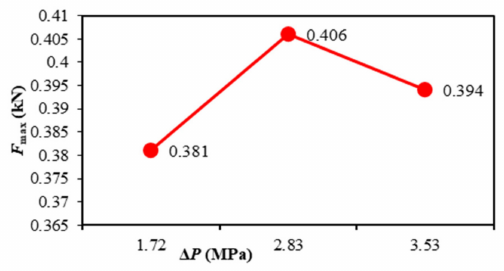
Figure 12. Variation in F max with ∆ P at the same frequency.